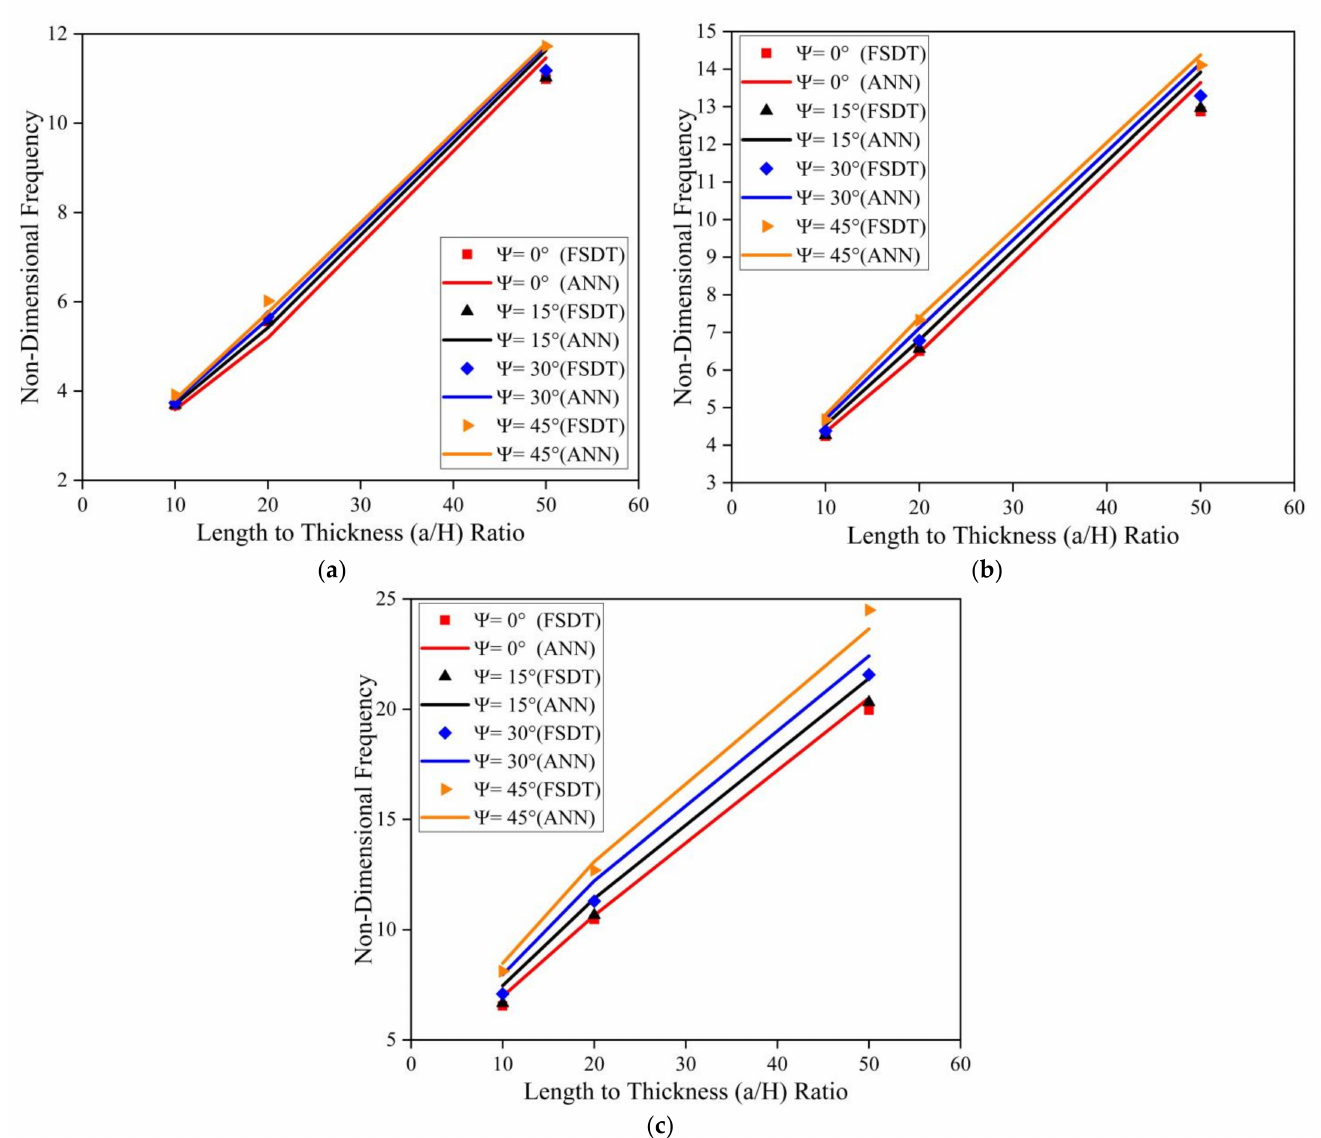
Figure 11. Influence of skew angle on the clamped skew LCS plate operating in an elevated thermal environment (325 K) for varying a/b and a/H ratios ( a ) a/b = 0.5 ( b ) a/b = 1.0 ( c ) a/b =